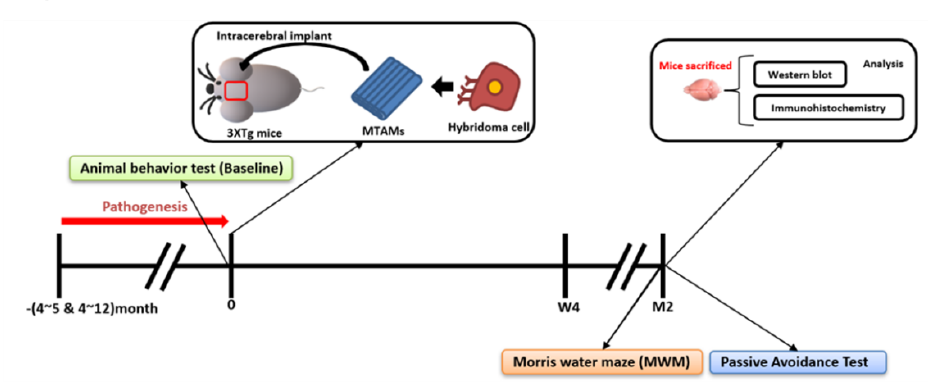
Figure 9. Overview of the animal model timeline. ( Bottom ) Overview on the memory timeline leading up to the Morris water maze for the examination of the short term and long term memory of the respective mice model.